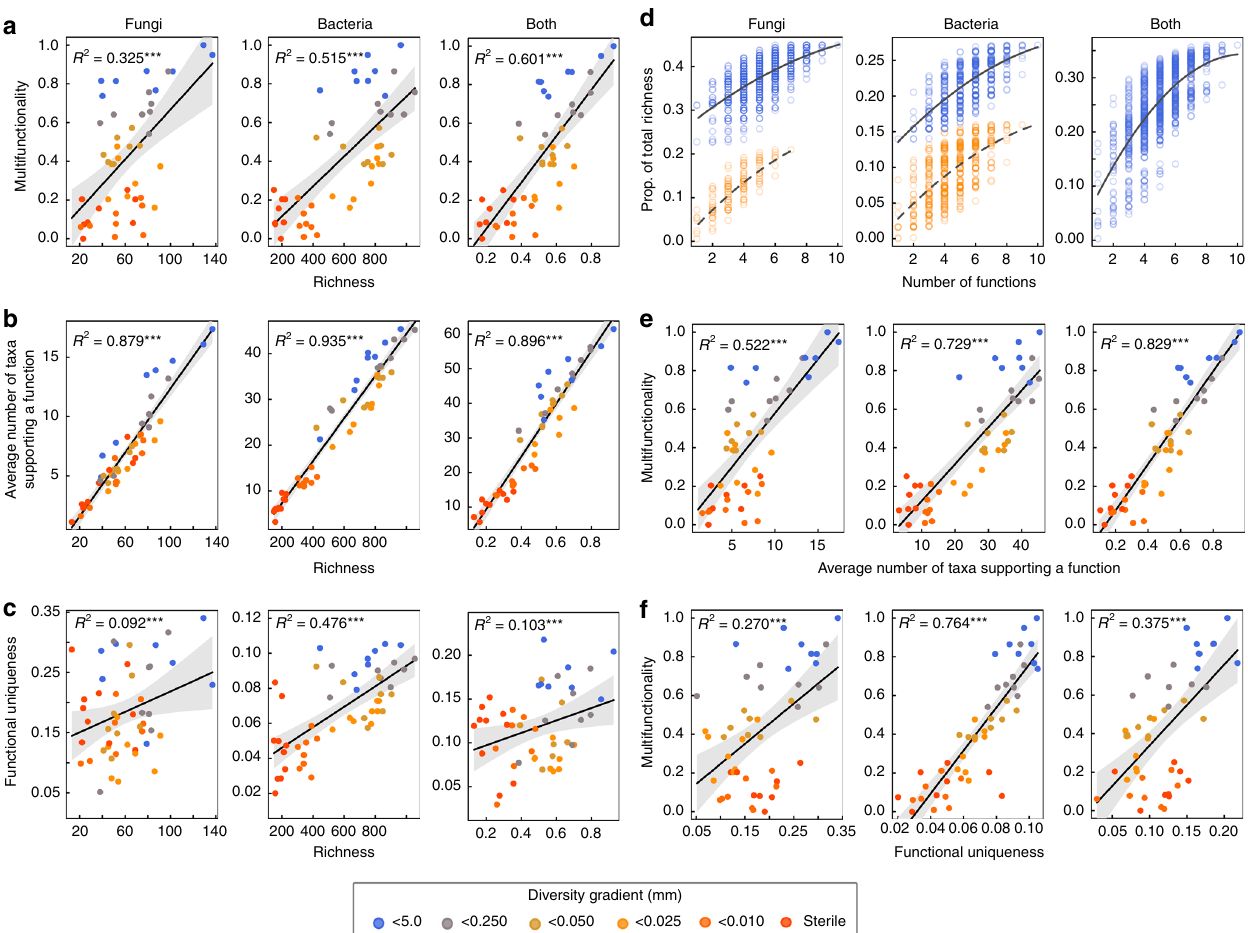
Fig. 2 Relationship between microbial composition indices and soil multifunctionality. The total fungal and bacterial OTU richness are shown in relation to a multifunctionality, b the average number of taxa that support a function, where larger values indicate that on average there are more taxa that support the same function, and c functional uniqueness where larger values indicate a greater dissimilarity among taxa in the functions they support. d Proportion of the microbial community needed to support a given combination of functions, from single functions to all 10 functions, illustrating that more taxa are needed to support multiple functions as more functions are considered 25 . Dashed regression lines show combinations of functions (in orange) that exclude P uptake by legumes and forbs and N uptake by legumes for fungi and N 2 O emissions for bacteria. These cluster out because these functions had a relatively high number of taxa that supported them (Table S5). Thus, there is a smaller proportion of the community that supports individual functions when these are excluded. Ecosystem multifunctionality was positively related to ( e ) the average number of taxa that support a function and ( f ) functional uniqueness. For a – c both fungi and bacterial richness was combined by taking their scaled (between 0 and 1) average richness. Signi fi cance is indicated